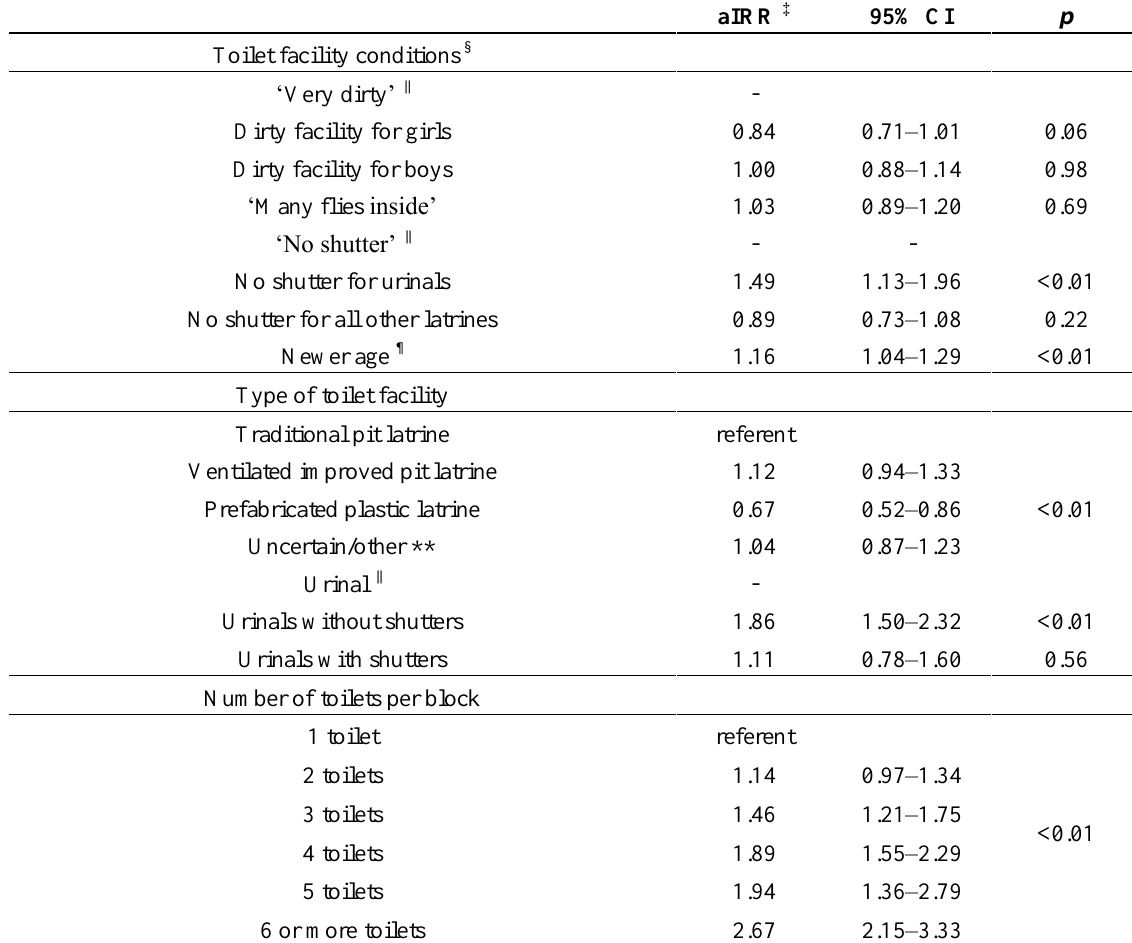
Table 4. Adjusted incidence rate ratio for facility use for each predictor of interest.